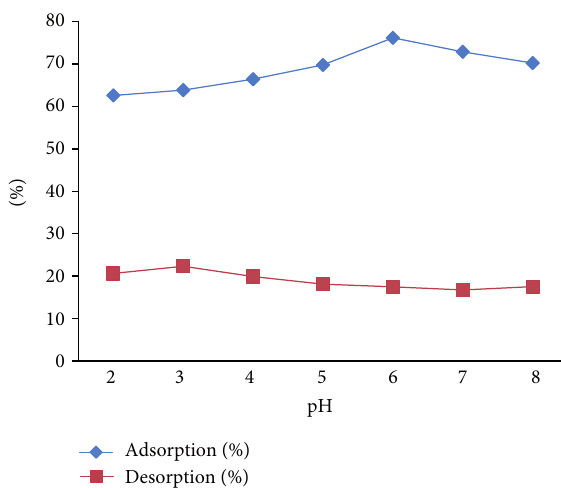
F 3: Percentage of adsorption and desorption of Cr (VI) onto